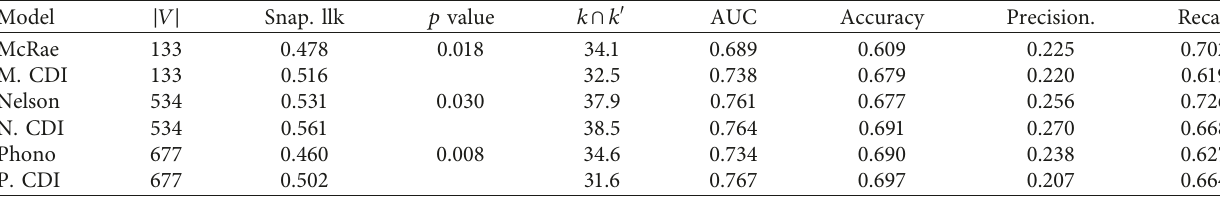
Table 3: Evaluation of model performance on test